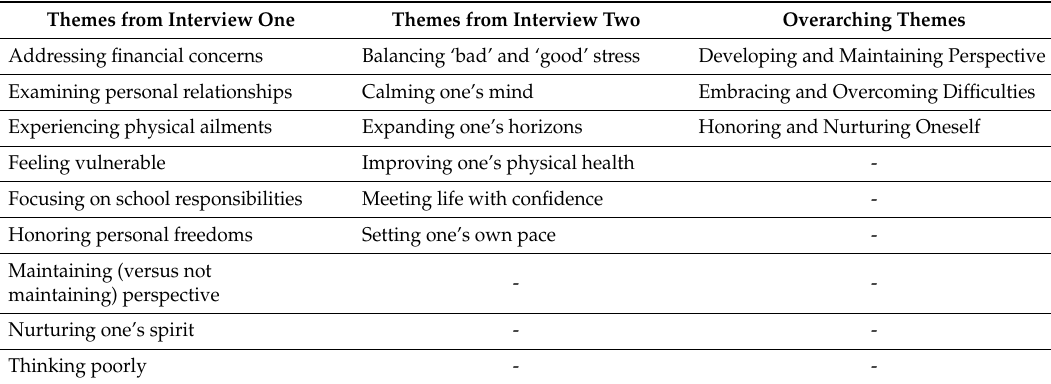
Table 1. Original Themes and Key Themes Resulting from